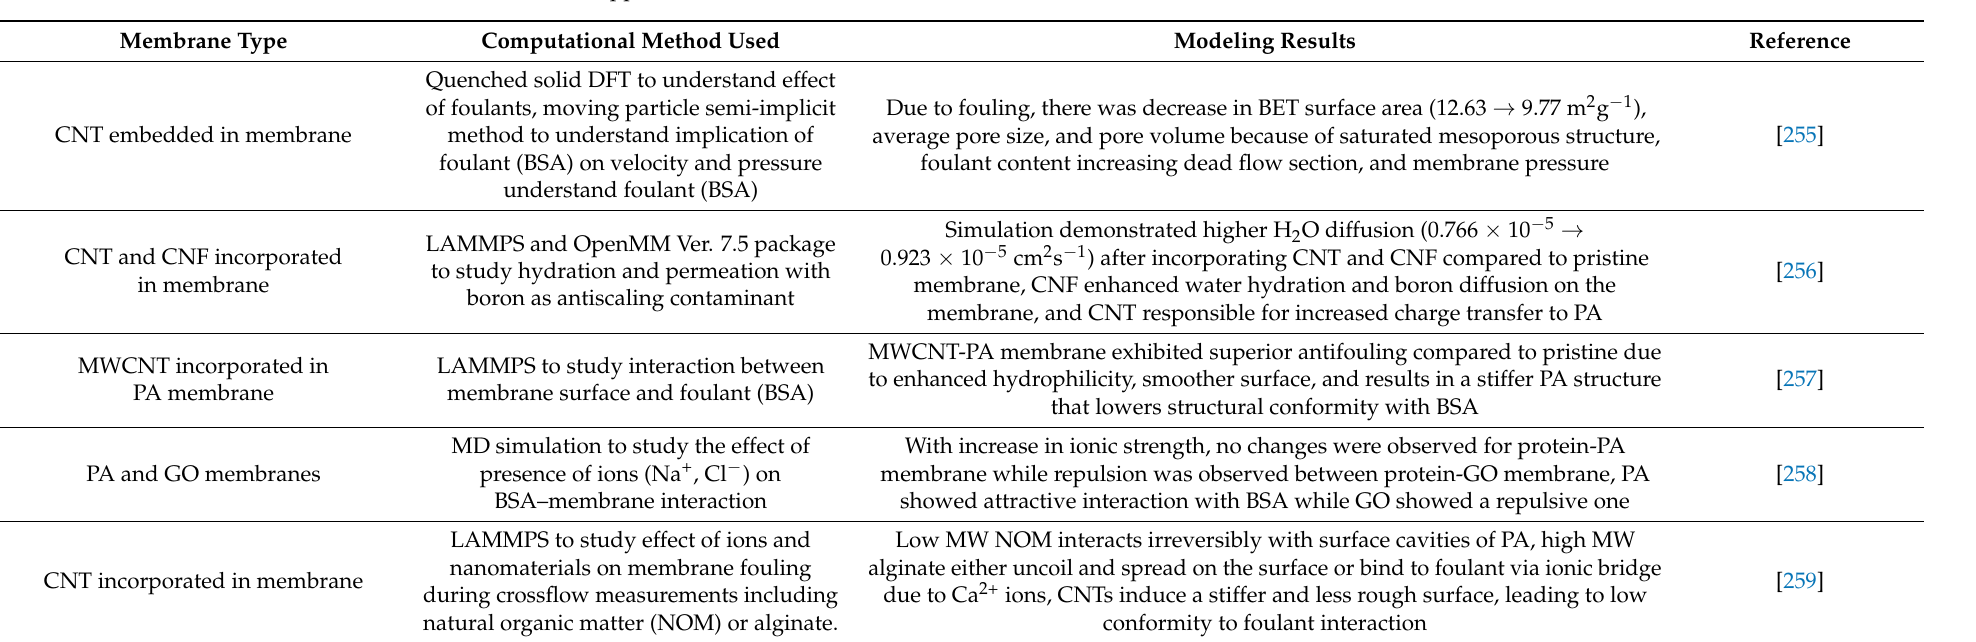
Table 5. A summary of findings of computational studies contributing to understanding foulant interactions, effect of ions, and hydration properties of PA membranes in desalination